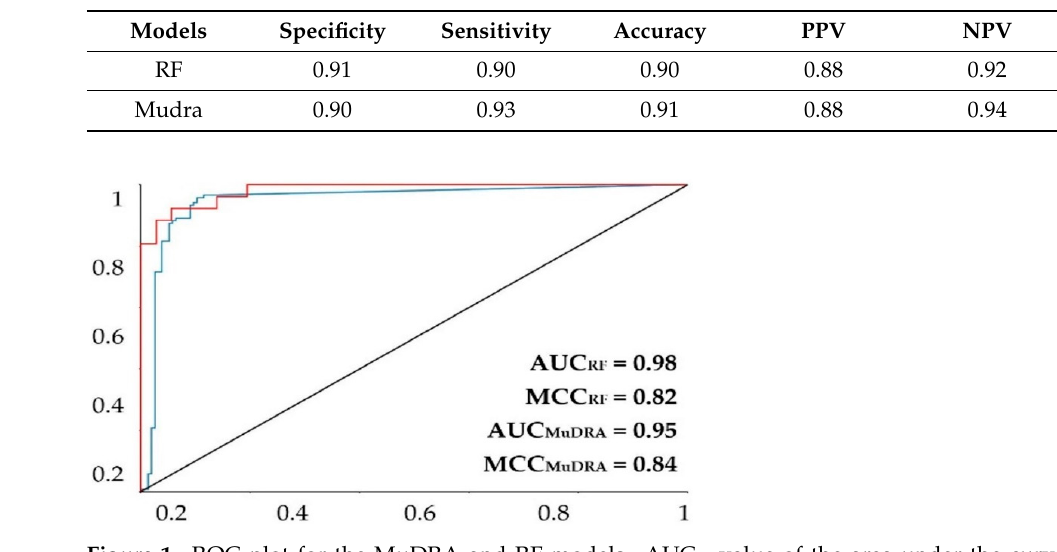
Figure 1. ROC plot for the MuDRA and RF models. AUC—value of the area under the curve; MCC—Matthews correlation coefficient. Red line—RF 5-fold external test cross-validation; blue line—MuDRA fivefold external test cross-validation.